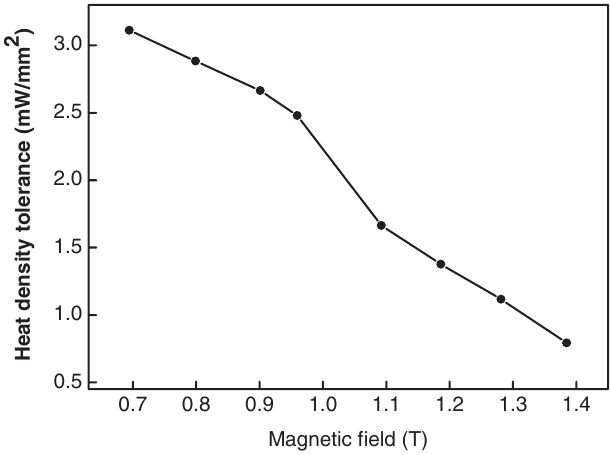
FIG. 3. Heat-load density as a function of magnetic-field strength at a coil-quenching